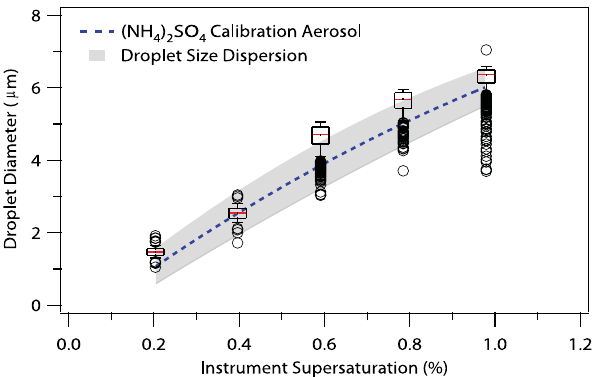
Fig. 12. Droplet growth kinetics study analysis. Box plots for am- bient droplet sizes at the point of activation by supersaturation. The whiskers represent the 10th and 90th percentile. Outliers shown as open circles represent those points that are 1.5 times the interquar- tile range (box width). The dashed blue line corresponds to the (NH 4 ) 2 SO 4 calibration droplet size at activation at the same super- saturation. The grey band represents the variability in the average calibration (NH 4 ) 2 SO 4 droplet